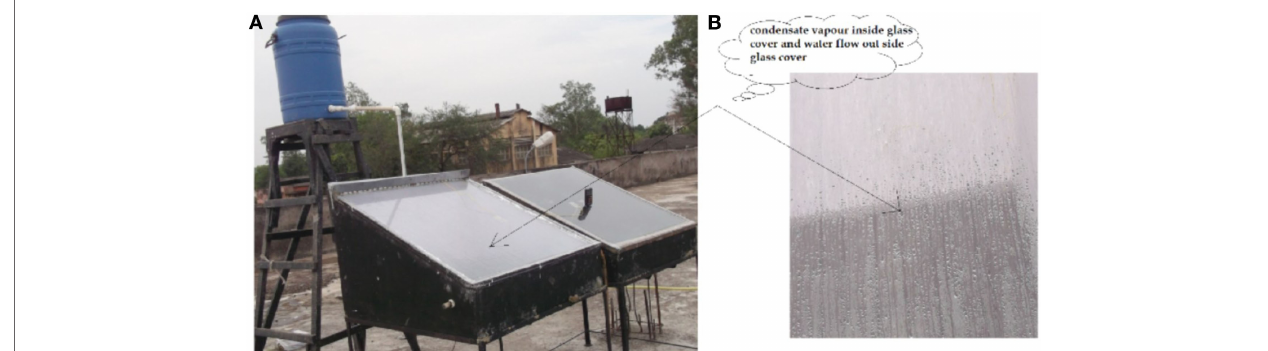
FIGURE 2 | Photograph of (A) working solar stills and (B) sprinkling of water on glass cover.